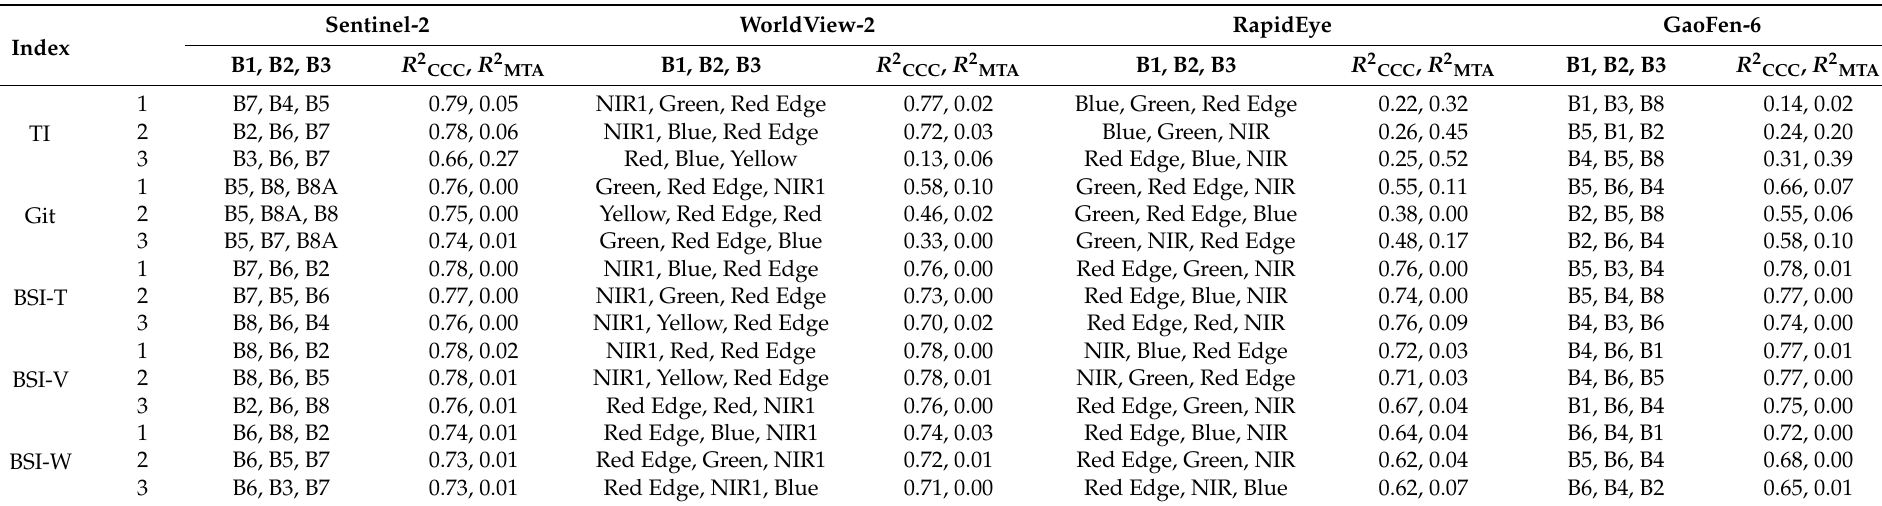
Table 4. Three best band configurations for the new three-band vegetation indices in the field measured dataset for each simulated